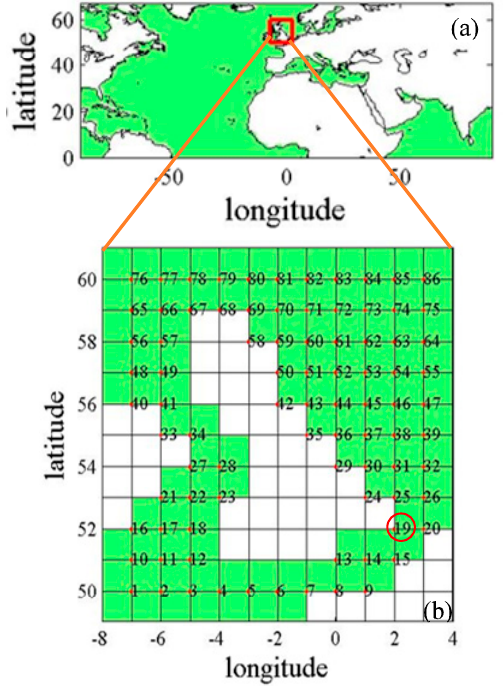
Figure 3. The global WAVEWATCH Ш model ( a ) and the nodes around UK area ( b ) (refer to [42], with permissions from Bennett et al, 2016). The node number stands for the nodes in the global wave model. We use the wave outputs at node 19 (red circle in figure b ).